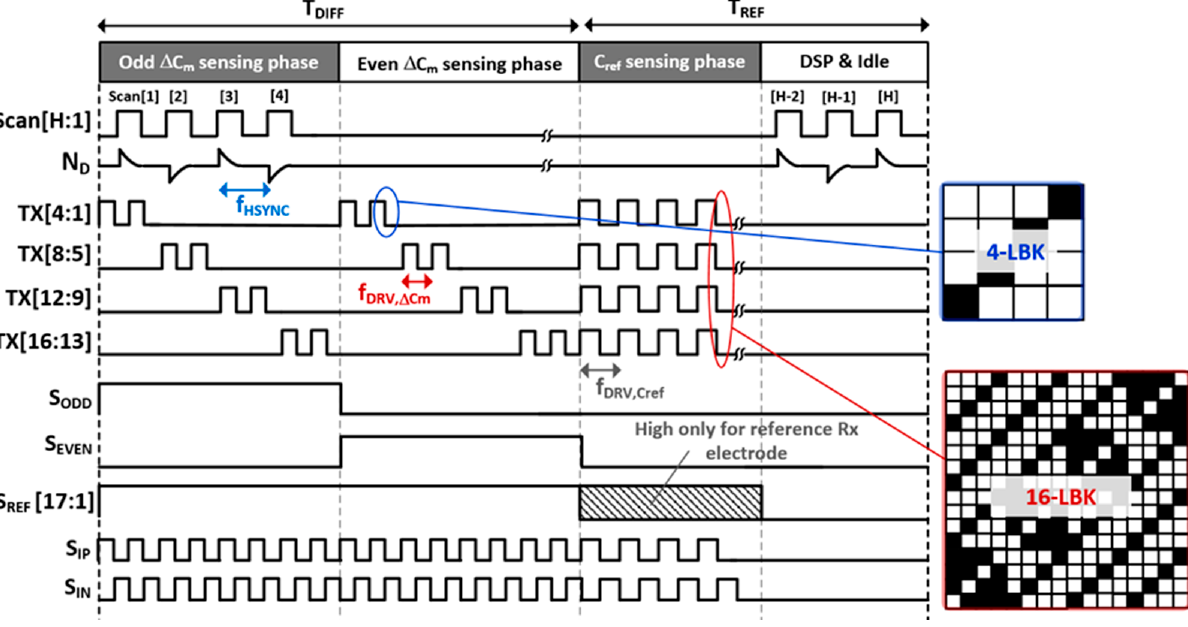
Figure 9. Timing diagram for illustrating the operation of proposed AFE with reconfigurable MCD sequences.